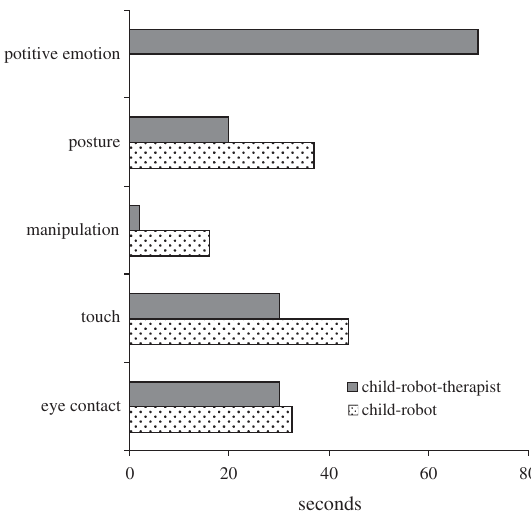
Fig.3. Totaldurationtimeofchild-robotinteractionandchild-robot- therapist interaction following each criterion.